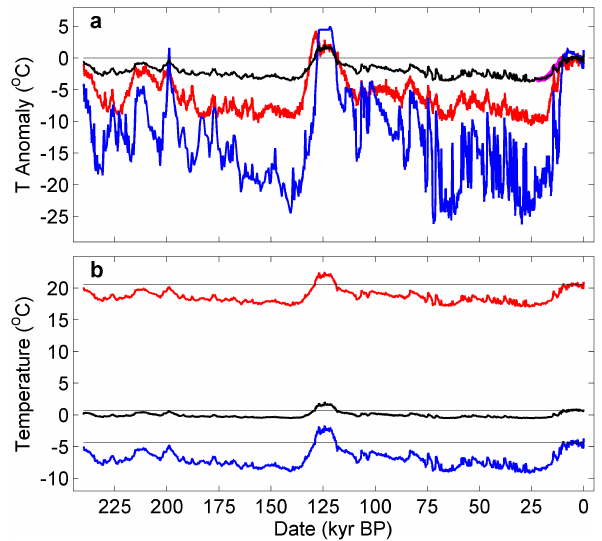
Figure A1. Input time series and DCESS model results used in the construction of a high-latitude, ocean subsurface temperature time series for forcing DAIS model hindcasts. Shown are (a) Antarctic and Greenland temperature anomalies (red and blue curves, respec- tively), a target time series for global mean temperature anomaly (short magenta line in upper right-hand corner) and calculated global mean temperature (black line) and (b) low- to middle-latitude and high-latitude zone atmospheric temperatures used to force the DCESS model ocean (red and blue lines, respectively) and calcu- lated high-latitude, ocean subsurface temperature (black line). The thin horizontal black lines in (b) mark present-day values (means for the period 1961–1990) for the respective time series. See Ap- pendix A for